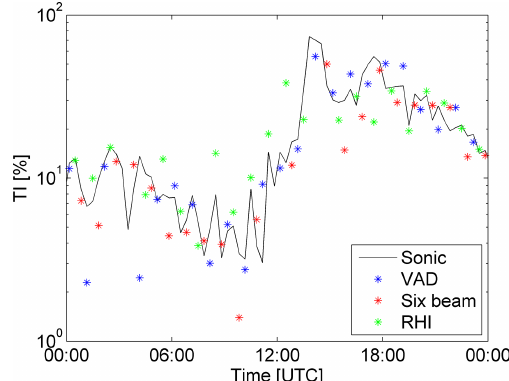
Figure 8. Sample time series of measured TI on 30 May 2015 at